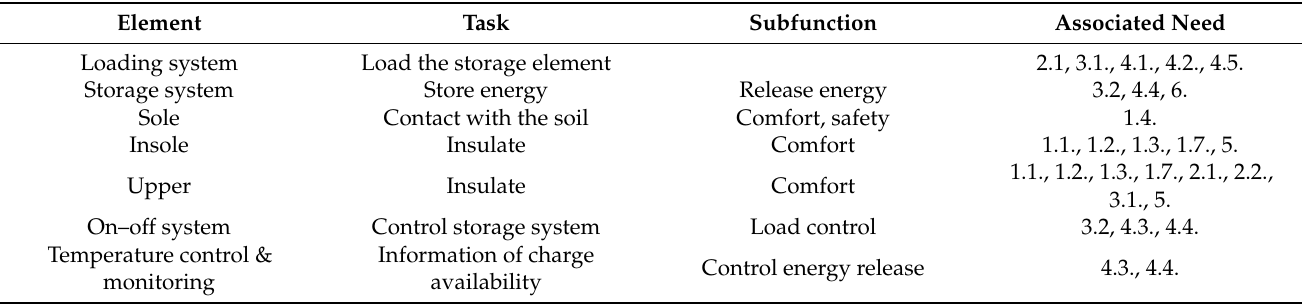
Figure 1. Product decomposition: ( a ) Physical decomposition; ( b ) Function decomposition (legend: M—material flow; E—energy flow; I—information flow). Table 9. Tasks and subfunctions of product’s